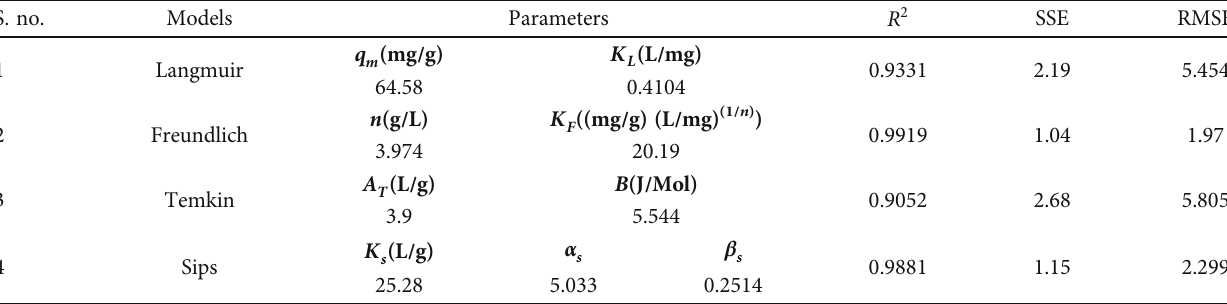
Table 1: Isotherm parameters and their goodness of fi t for MG dye adsorption onto ultrasonic-assisted egg shell (UAESP). S.